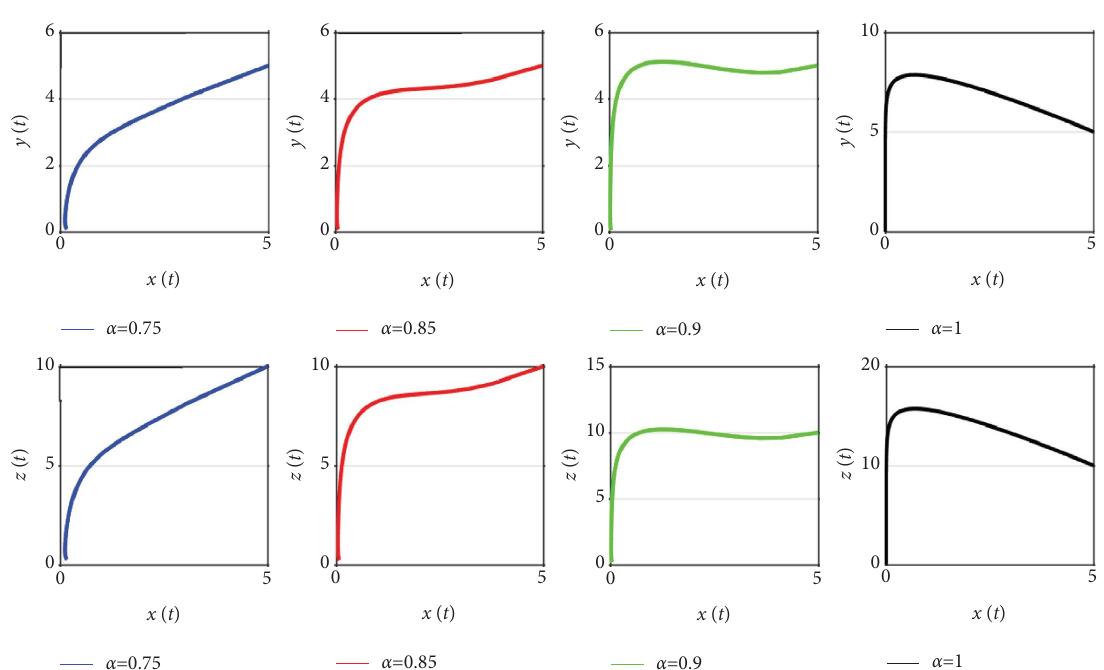
Figure 11: Phase space for the one prey-two predators system, where D ( x ) � 0 , G ( y ) � − g � − 0 . 01 , J ( z ) � 0 , a � b � c � 0 . 1 , e � h � 0 . 3 , f � i � 0 . 2, α � 0 . 75 , 0 . 85 , 0 . 9 , 1